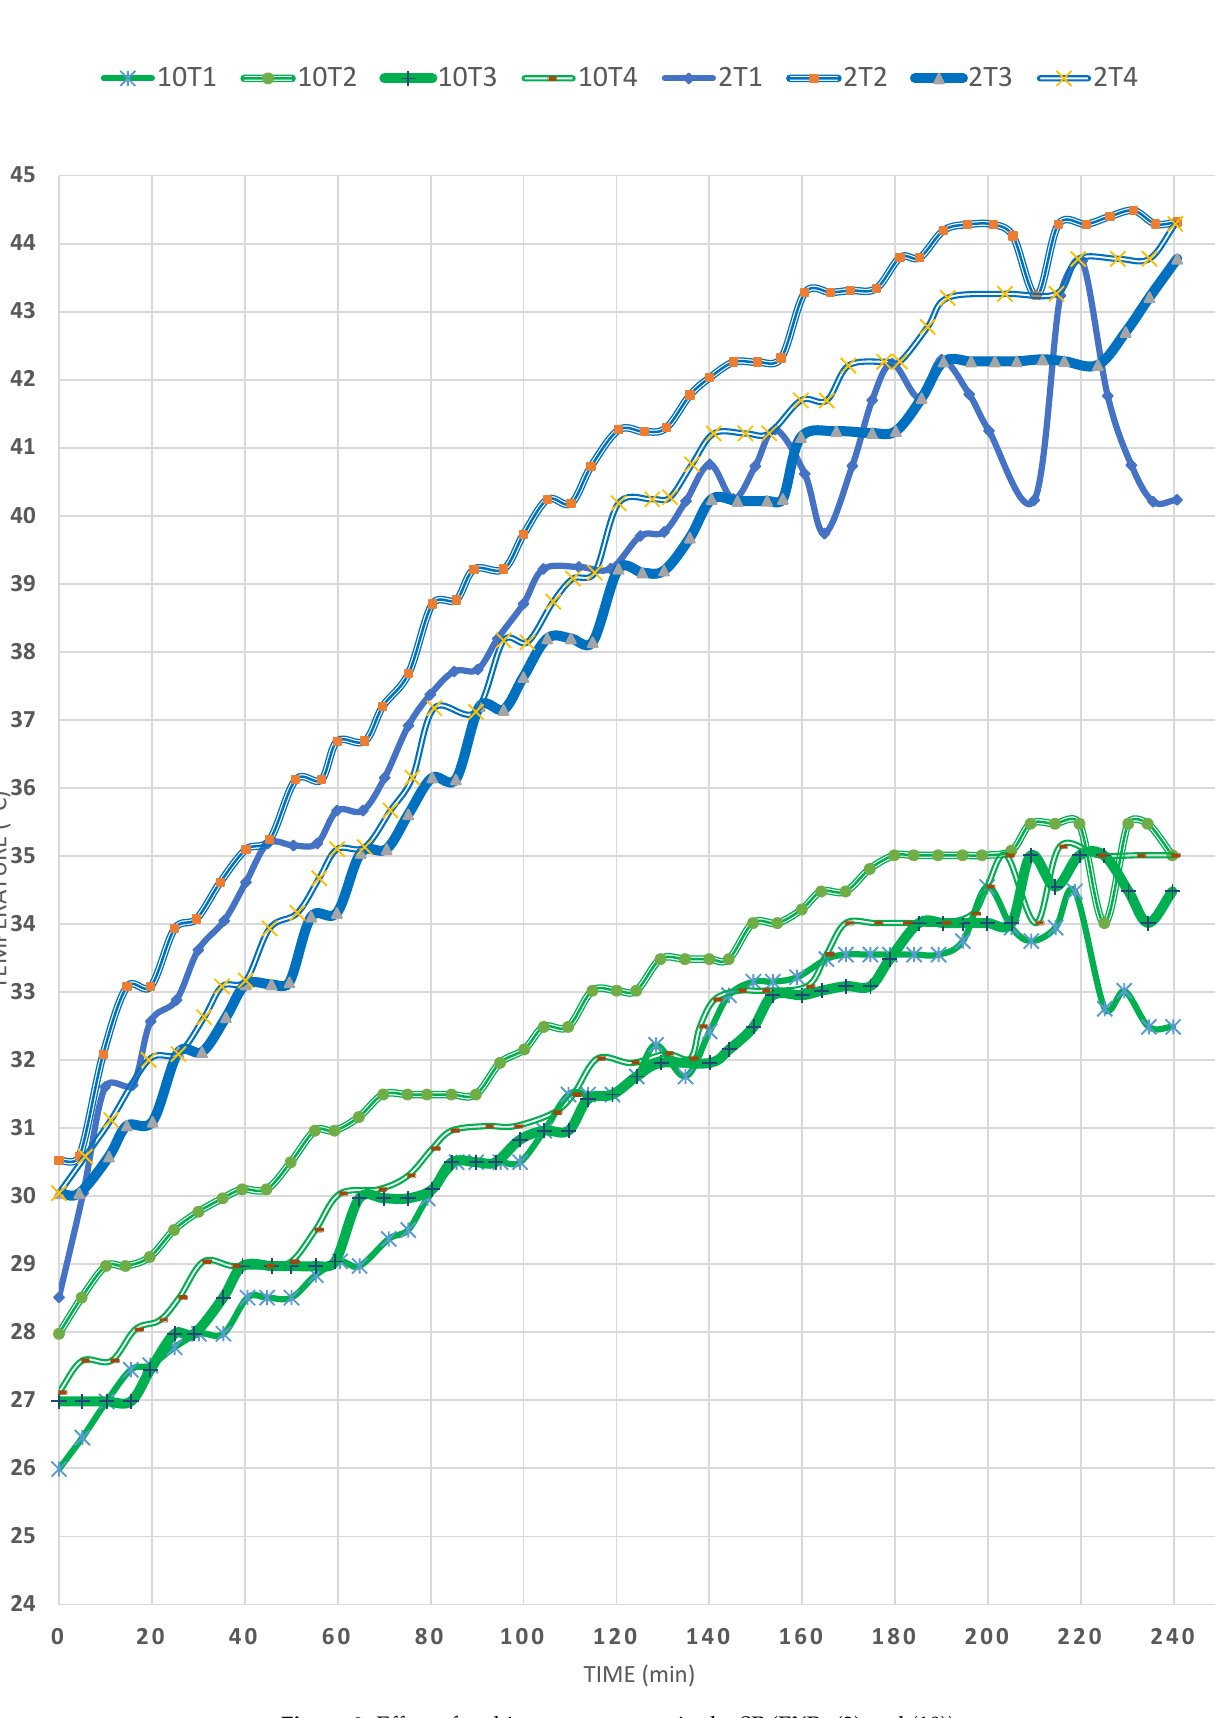
Figure 9. Effect of ambient temperature in the SP (EXPs (2) and (10)).